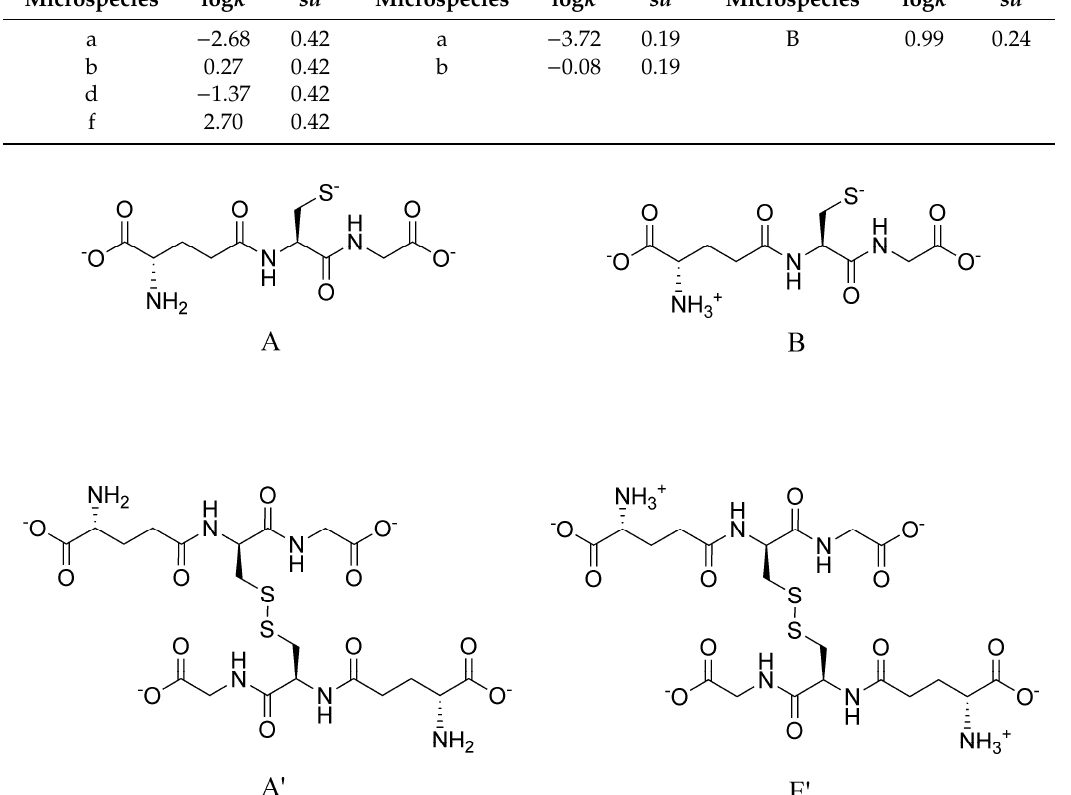
Figure 6. The structure and protonation states of the referenced glutathione (A, B, top) and glutathione disulfide (A’, E’, bottom) microspecies in this work.